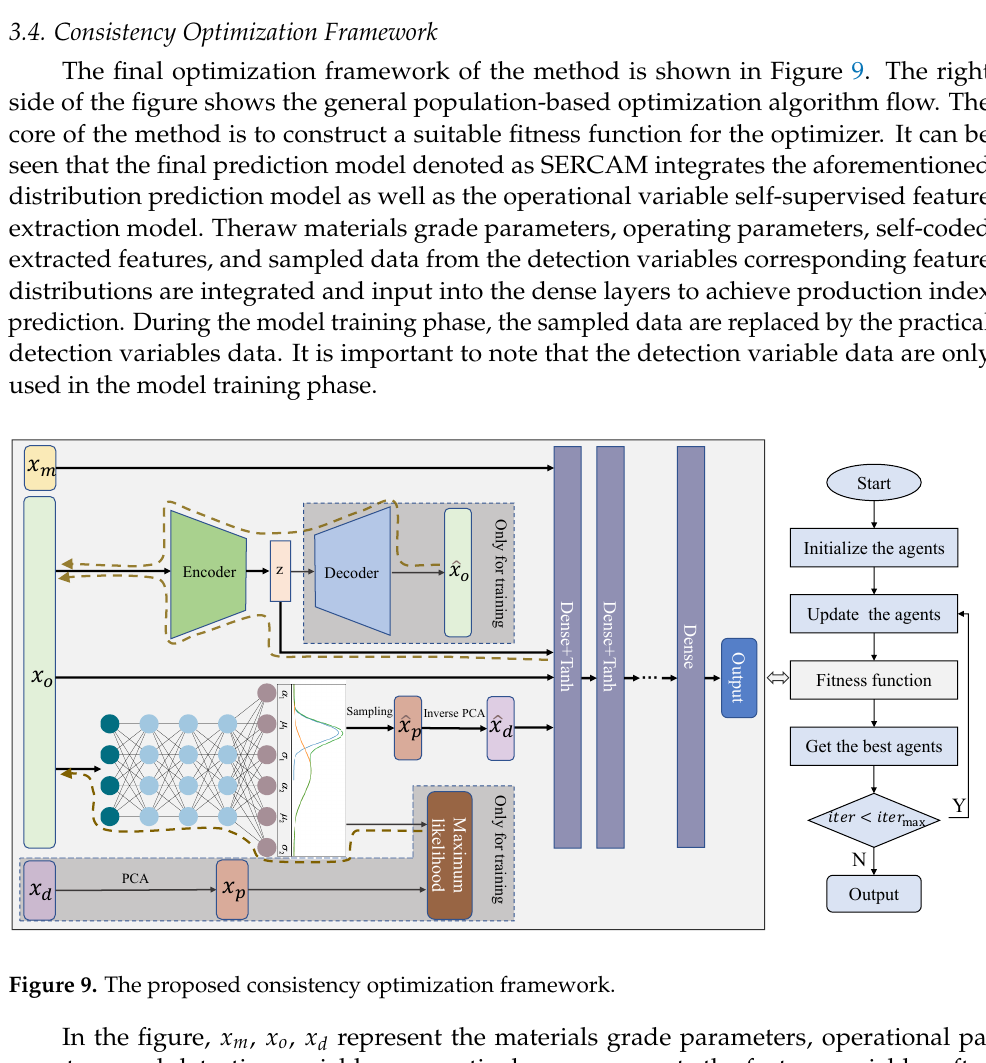
Figure 8. Schematic diagram of the self-encoding regression method.